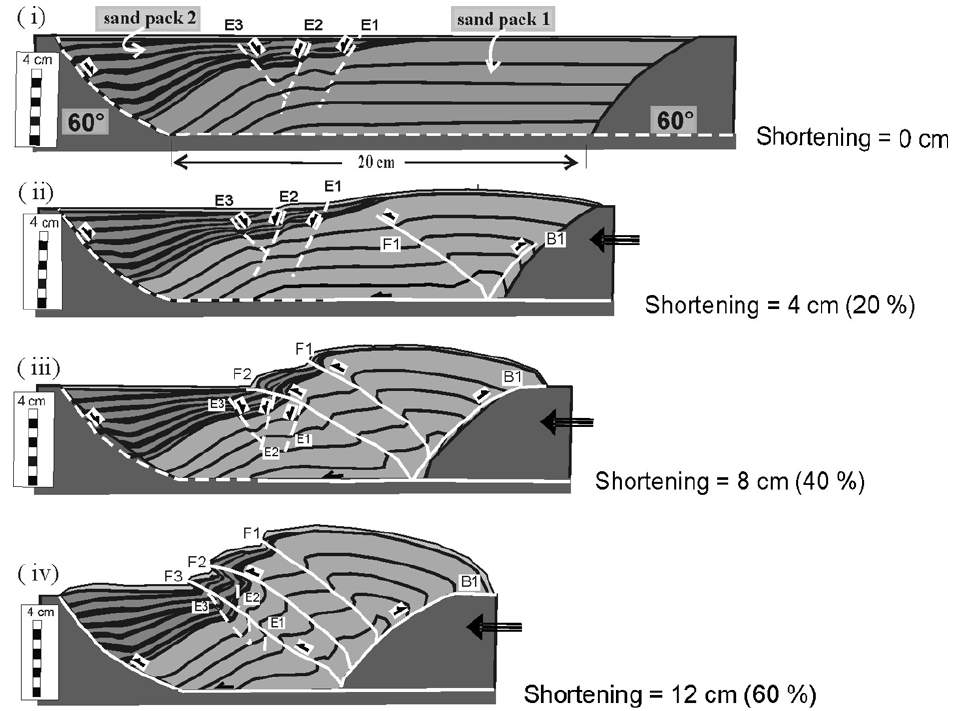
Fig. 4 – (i-iv) Sequential line drawings of inversional steps of photographs taken through the transparent sidewalls of model 1 ( α and β = 60 ◦ ). E1-E3 are structures that were formed during extensional steps; F1-F3 are forethrusts, and B1, a backthrust. Dashed and continuous lines represent extensional and compressional structures,